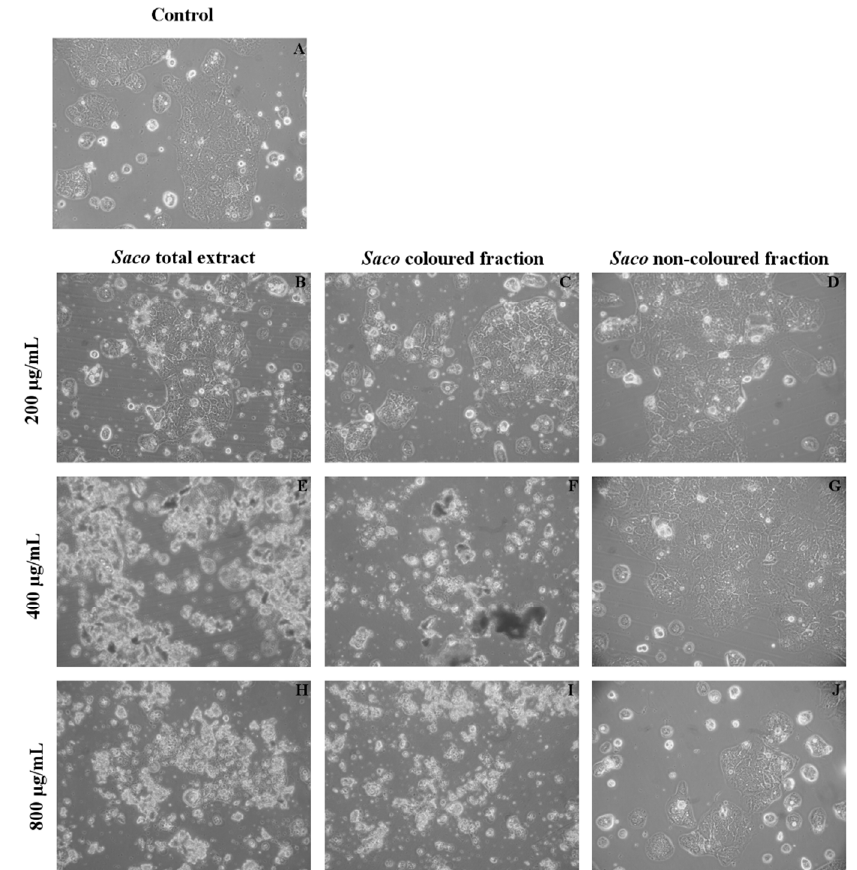
Figure 5. Morphological assessment of Caco-2 cells (control vs. treatment after 24 h of incubation). ( A ) corresponds to the control, ( B , E , H ) correspond to Saco total extract, while ( C , F , I ) to the colored fraction and ( D , G , J ) to the non-colored one, at concentrations of 200, 400 and 800 µ g/mL, respectively. As expected and considering the data of Figure 4, it was observed an increase in debris as the concentration of each fraction increased.